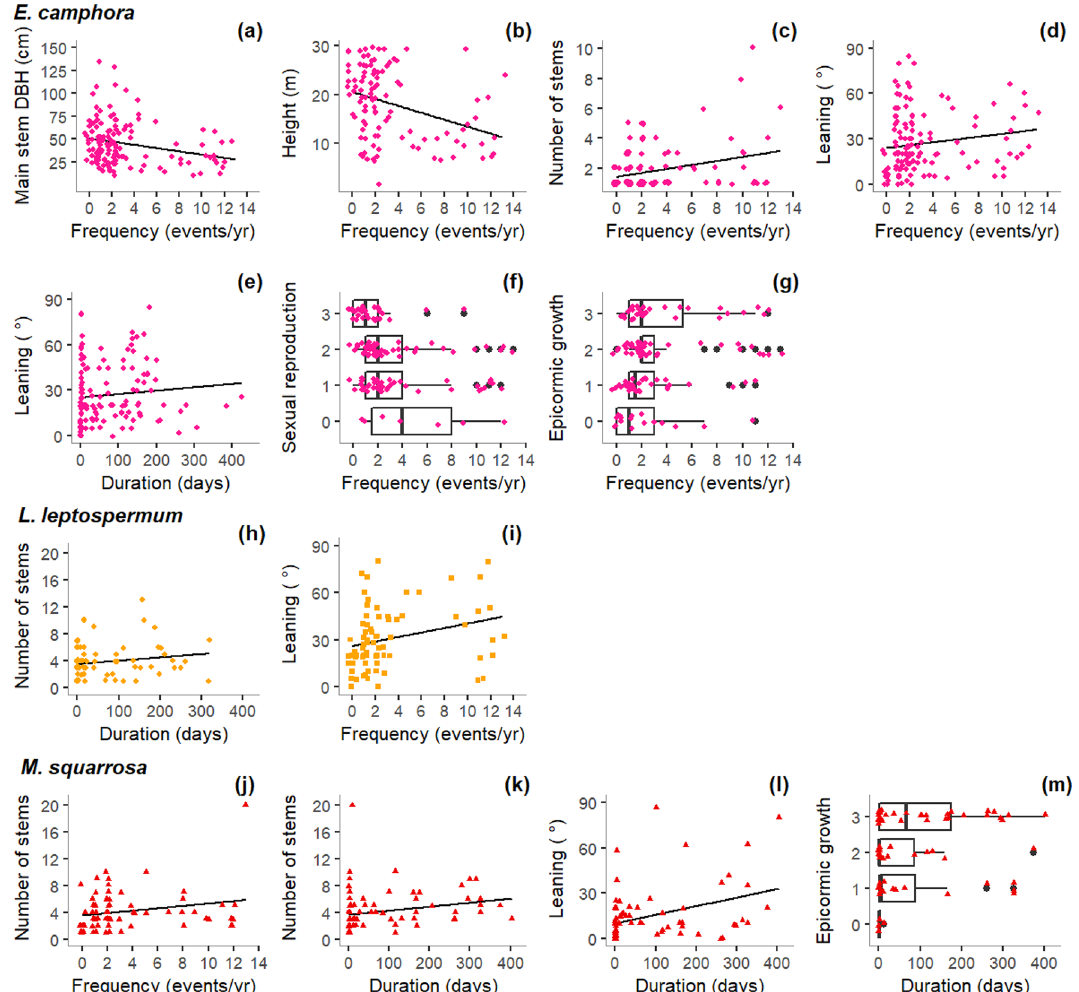
Figure 4. Relationships of flood duration and frequency and measured morphology variables, sexual reproduction and epicormic growth for E. camphora , L. lanigerum and M. squarrosa . Only relationships from models with R 2 or pseudo R 2 > 0.05 and for predictor variables with a significant independent contribution to the overall explained variance > 0.30 are shown. Note that plots show untransformed values for flood duration and frequency whereas statistical modelling was undertaken using log transformed values. Points indicate raw data (n = 129 for E. camphora , n = 75 for L. lanigerum , n = 74 for M. squarrosa ). Frequency (events/year) = mean number of flooding events per year; duration (days) = mean flooding event duration; sexual reproduction = score for sexual reproduction; epicormic growth = score for epicormic growth. The figure was generated in R version 3.5.0 (https:// www.r- proje ct.